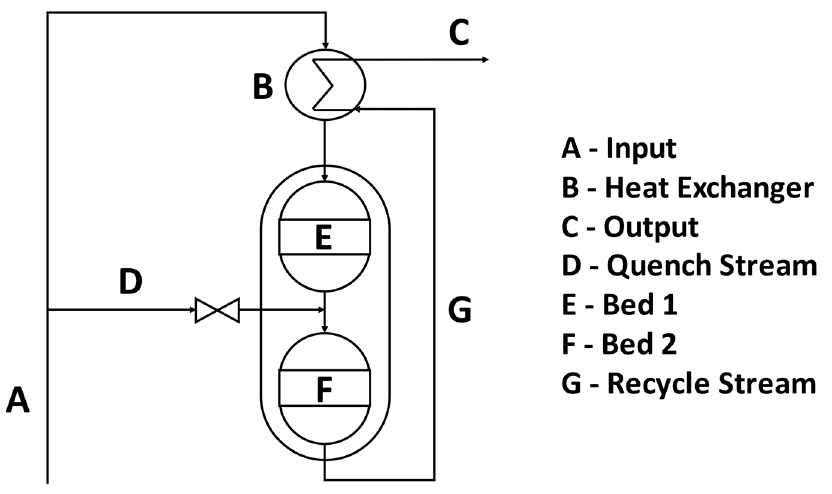
Figure 2. Schematic diagram of the ammonia synthesis step, depicting the multiple stages and interstage quench stream for cooling.